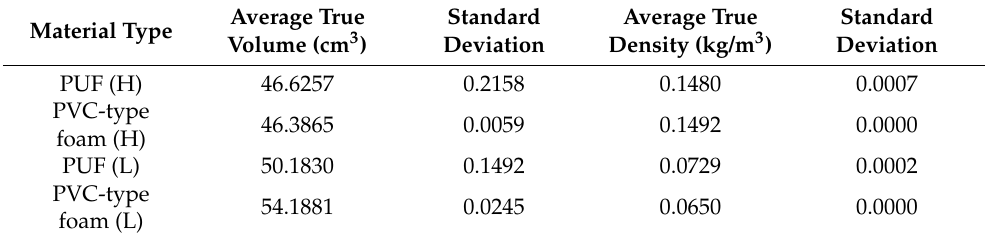
Table 3. Results of the true densities of the two types of materials.